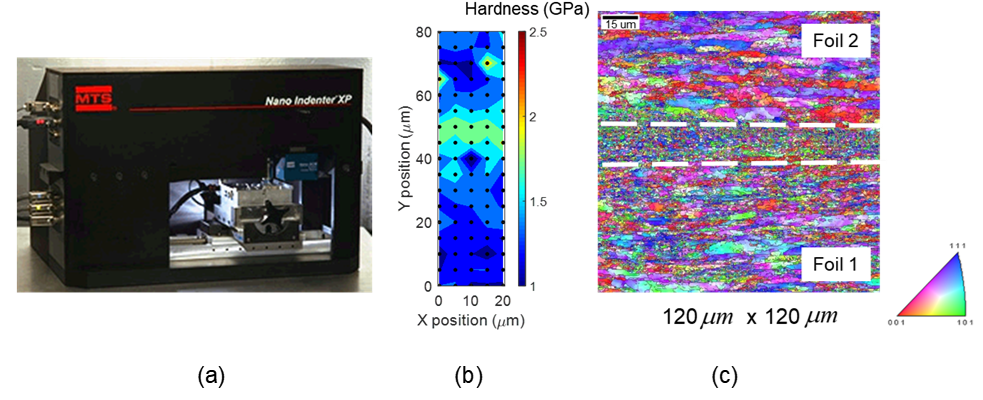
Figure 4. Measurement of local hardness of UAM-welded Al 6061-H18: ( a ) MTS Nano Indenter XP with a Berkovich indenter used to perform nanoindentation; ( b ) map of local hardness measured with a spacing of 5 µm; ( c ) Inverse Pole Figure (IPF) from EBSD analysis of a UAM weld with the weld interface region shown using white dashed